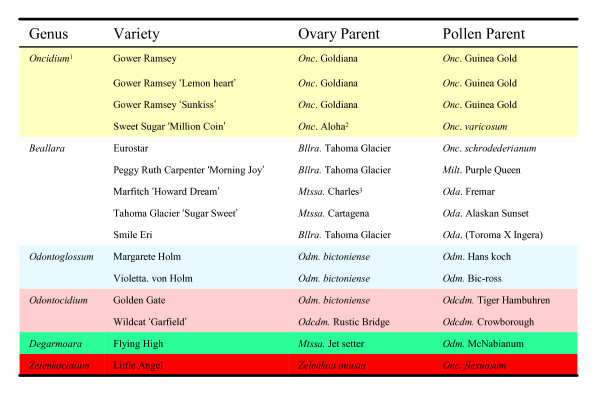
Parents of 15 varieties of Oncidiinae. 1Yellow background: Oncidium; white: Beallara; blue: Odontoglossum; purple: Odontocidium; green: Degarmoara; red: Zelenkocidium. 2Onc. Aloha = Onc. Goldiana × Onc. Star Wars. 3Mtssa Charles = Brassia verrucosa × Milt. spectabilis.